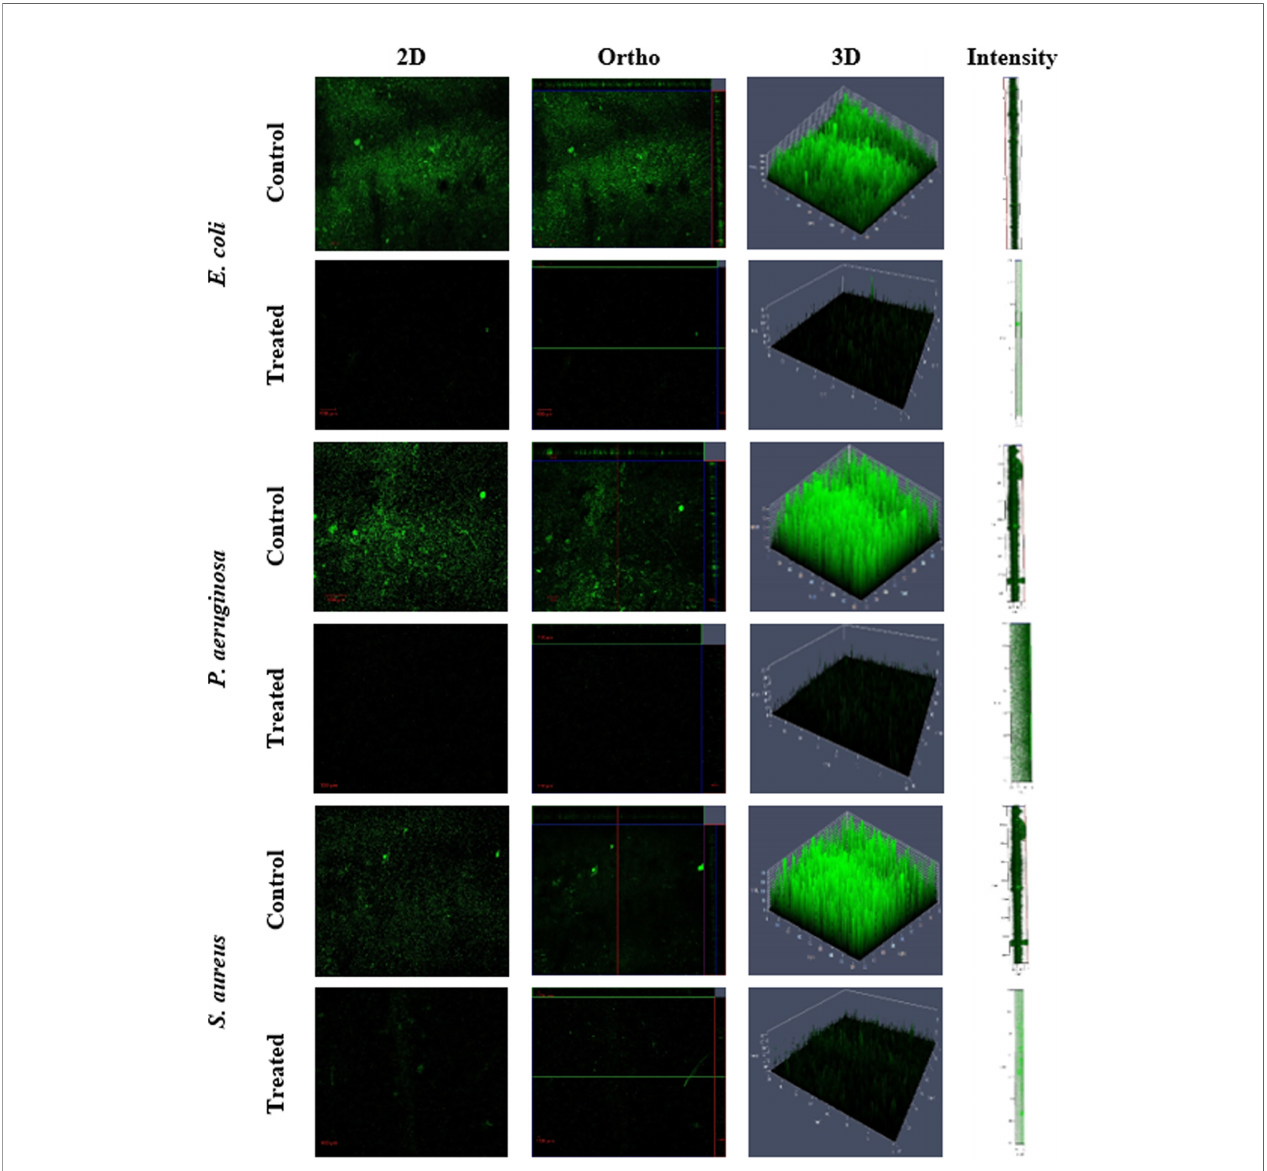
FIGURE 6 | Confocal scanning laser microscopy images of bio fi lm formation on glass microscopic coverslips of control and NHP-treated (200 µg/ml) human clinical pathogens E. coli , P. aeruginosa , and S. aureus